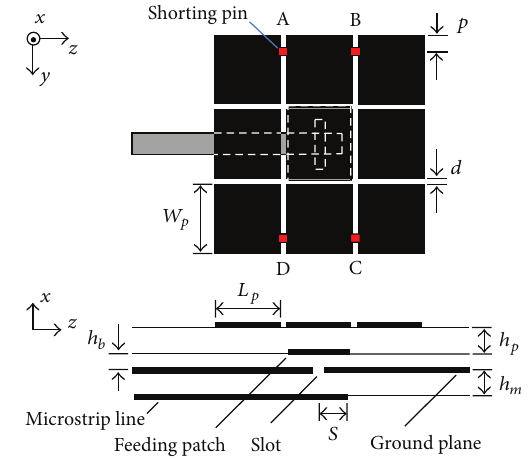
Figure 1: Top view and side view geometries of the reconfigurable aperture coupled stacked microstrip antenna with gridded parasitic